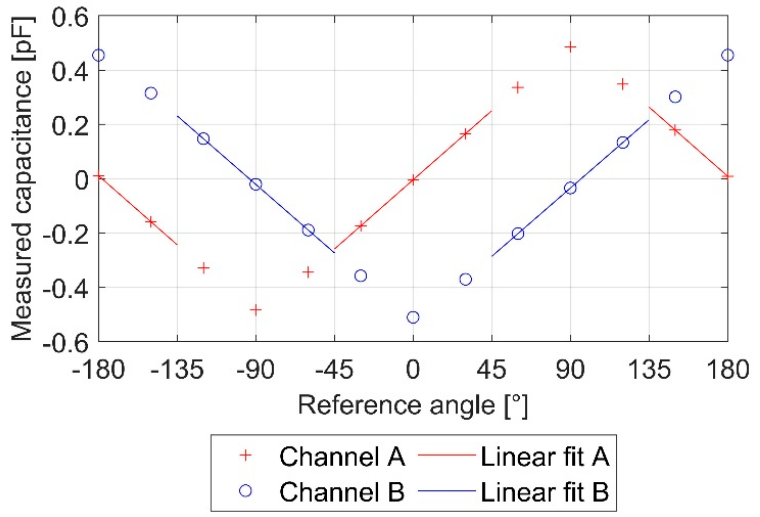
Figure 7. Characteristic curve LP1 with linear fit.